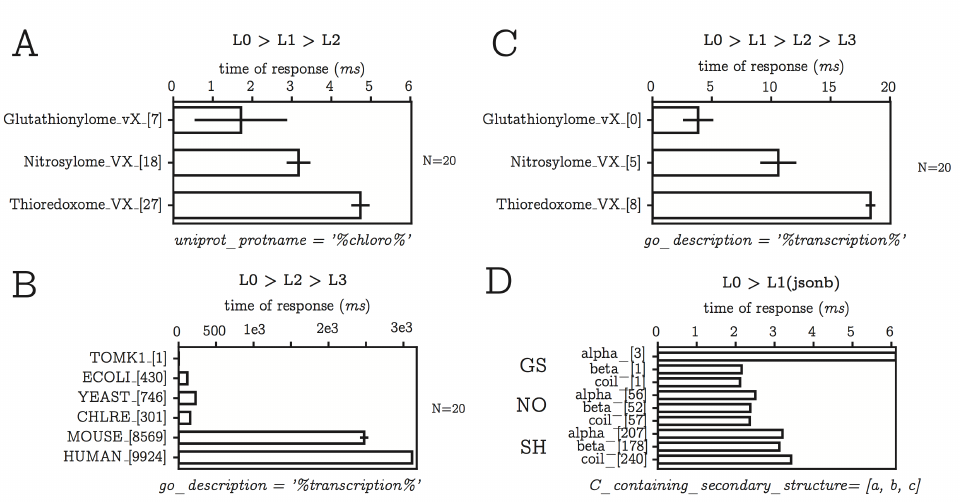
Figure 4: MinOmics filtering performances. The efficiency of filtering is measured as the time of response of fetching fil- tered data sets through the different layers of the MinOmics database. Timing for partial pattern matching on text data types is reported in (A, B, C). Complete pattern matching is performed on jsonb data-type as reported in (D). Patterns and queried keys are indicated below each panel. The standard error for N tests is indicated and the queryset size is given between brackets.